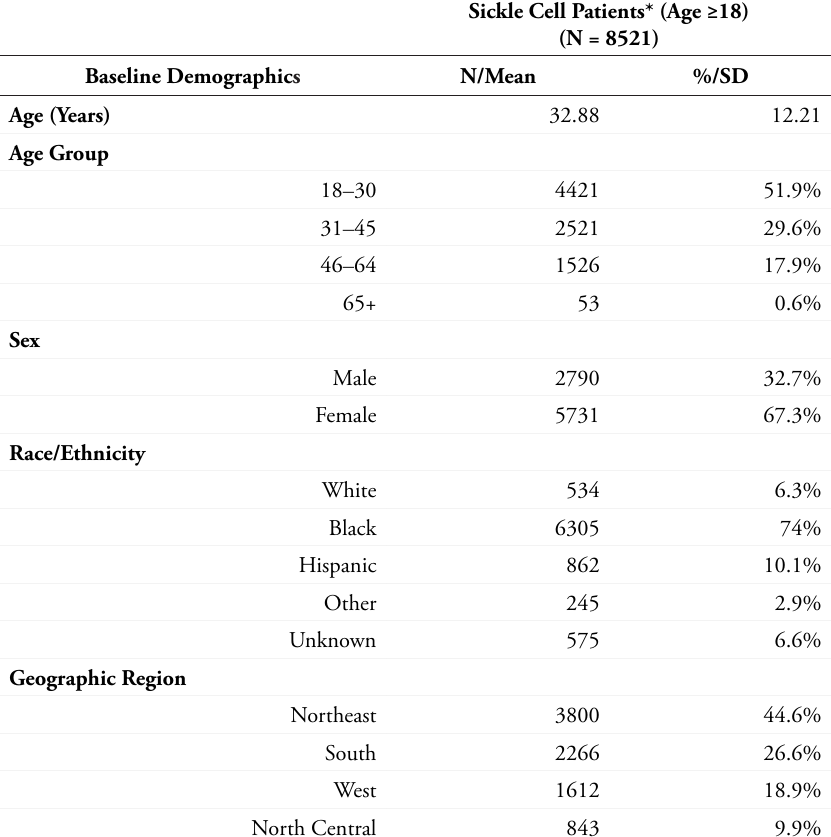
Table 1. Patient Demographic